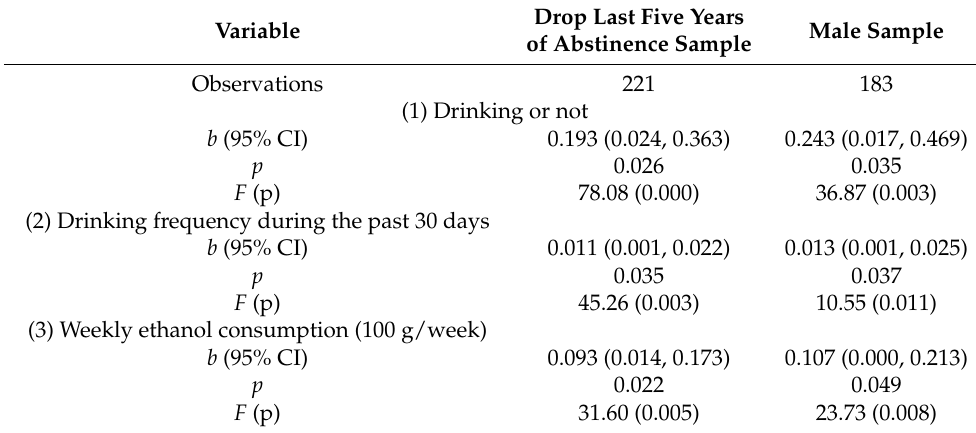
Table 3. Sensitivity analysis of alcohol consumption on MCI–2SLS estimation results.